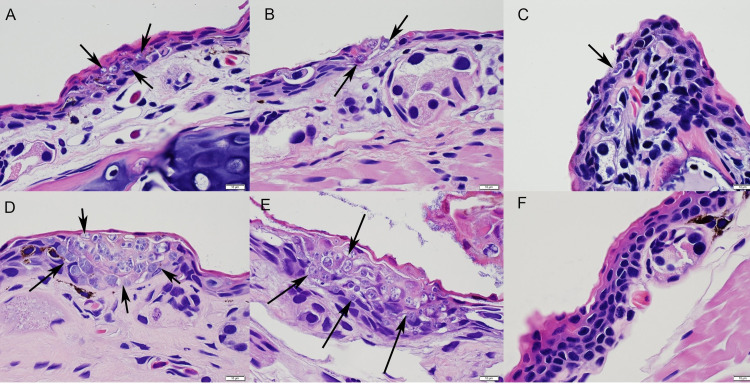
Hematoxylin and Eosin stained sections of skin from Notophthalmus viridescens exposed to Batrachochytrium salamandrivorans (Bsal) zoospores (doses = 5x103-6 per 10 mL).Fungal organisms (arrows) were observed invading the epidermis of juveniles (efts) at all temperatures, 6, 14, and 22°C (A, B and C, respectively), but only at 6 and 14°C for adults (D and E, respectively). No invasion was observed in adult skin exposed at 22°C, even at the highest dose of 5x106
Bsal zoospores (F).